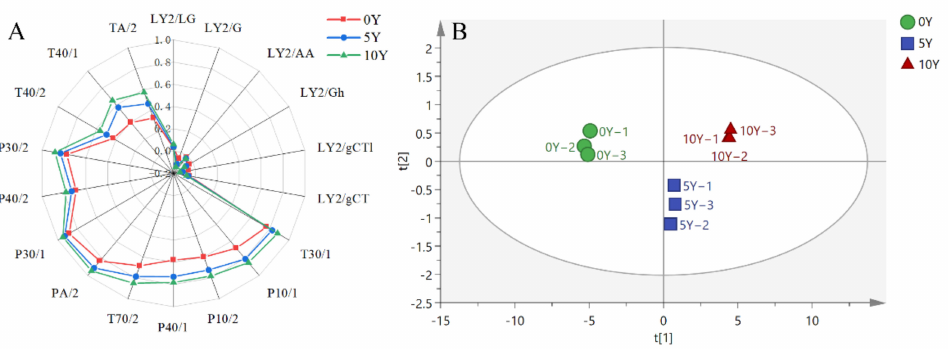
Figure 6. E-nose analysis. ( A ) Radar graph of the three different industrially fermented kohlrabies. Blue, red, and black indicate 0Y, 5Y, and 10Y industrially fermented kohlrabies, respectively. ( B ) PCA plot of the three different industrially fermented